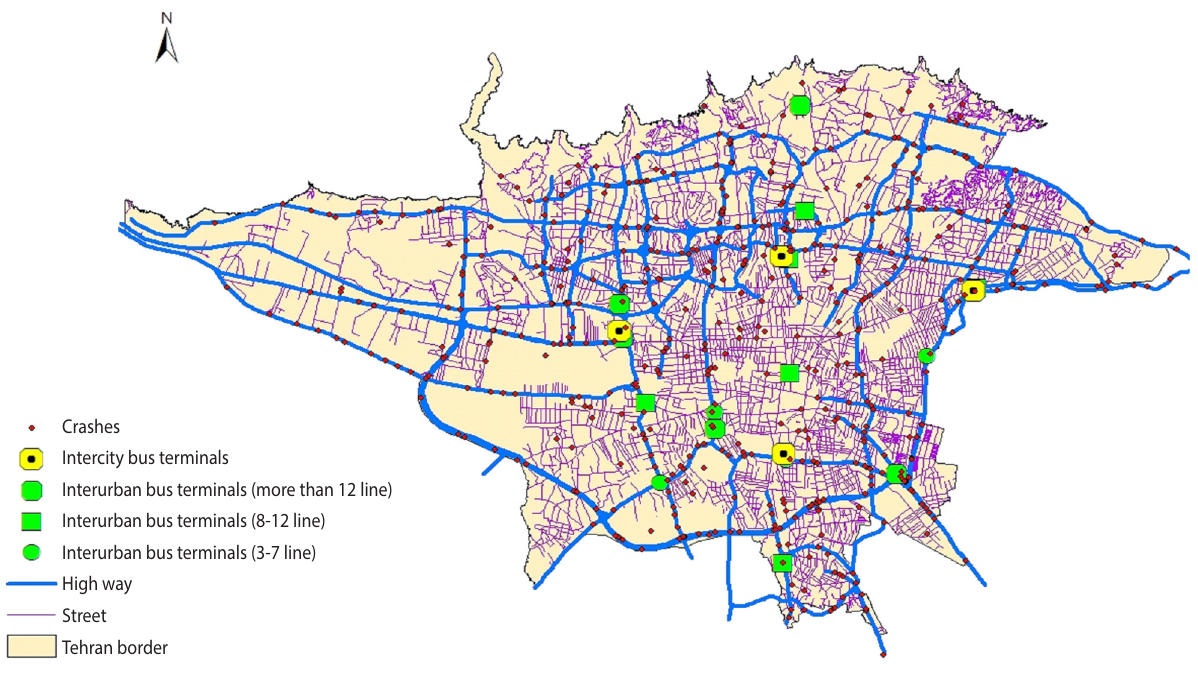
Figure 3. Distribution of studied traffic collisions in Tehran and their location relative to highways and bus terminals during April 2014 to March